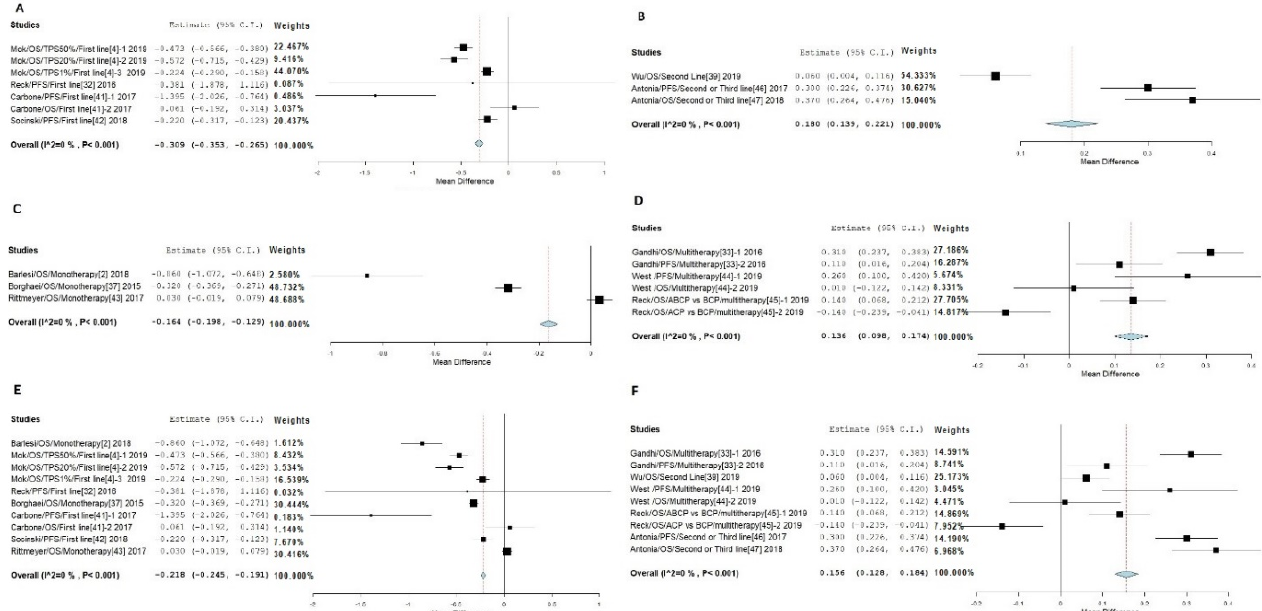
Figure 3. Stratified meta-analysis of PD-1/PD-L1 drugs on NSCLC between smokers and non-smokers. ( A ) First-line treatment. ( B ) Second- and third-line treatment. ( C ) Monotherapy. ( D ) Combined with other treatments. ( E ) Patients’ response when treated as first and monotherapy (RE). ( F ) Patients’ response when treated as second-line and multi-therapy (RE).